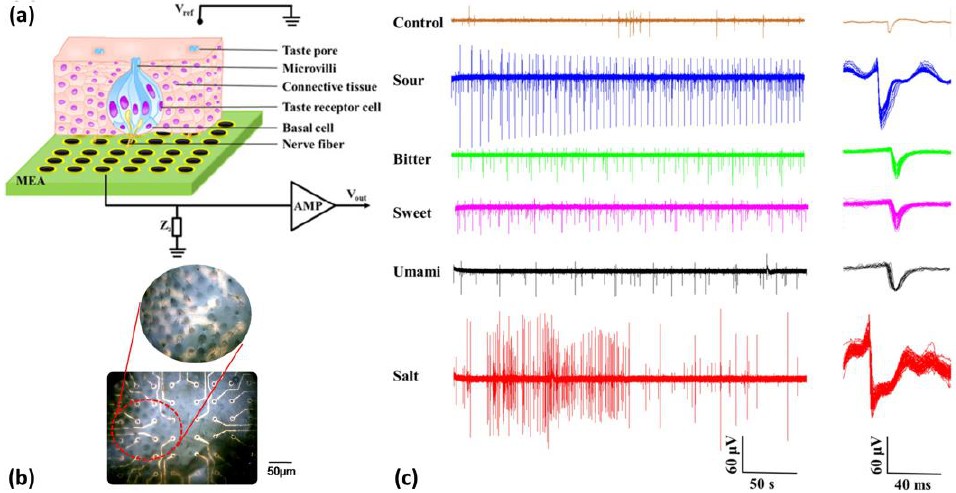
Figure 3. ( a ) Schematic diagram of in vitro biosensing approach using taste epithelium coupled with MEA chip; ( b ) Image of taste epithelium coupled with MEA chip; ( c ) Recorded typical responsive electrophysiological signals upon the stimulations of five basic taste qualities [67,68].